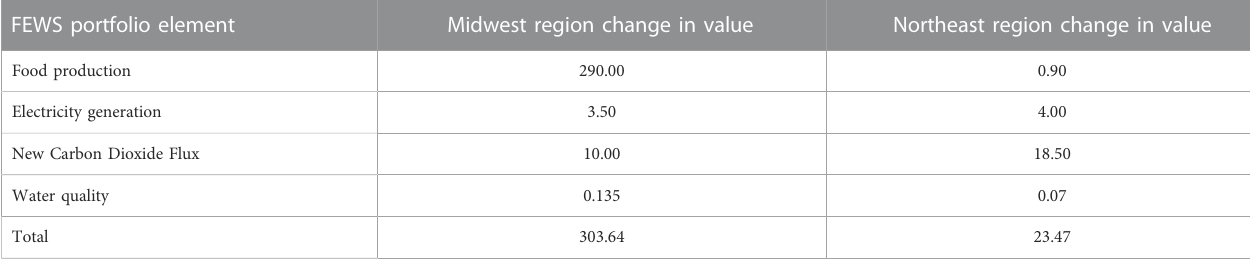
TABLE 6 Heat-wave scenario aggregate results by C-FEWS element and study region. FEWS portfolio